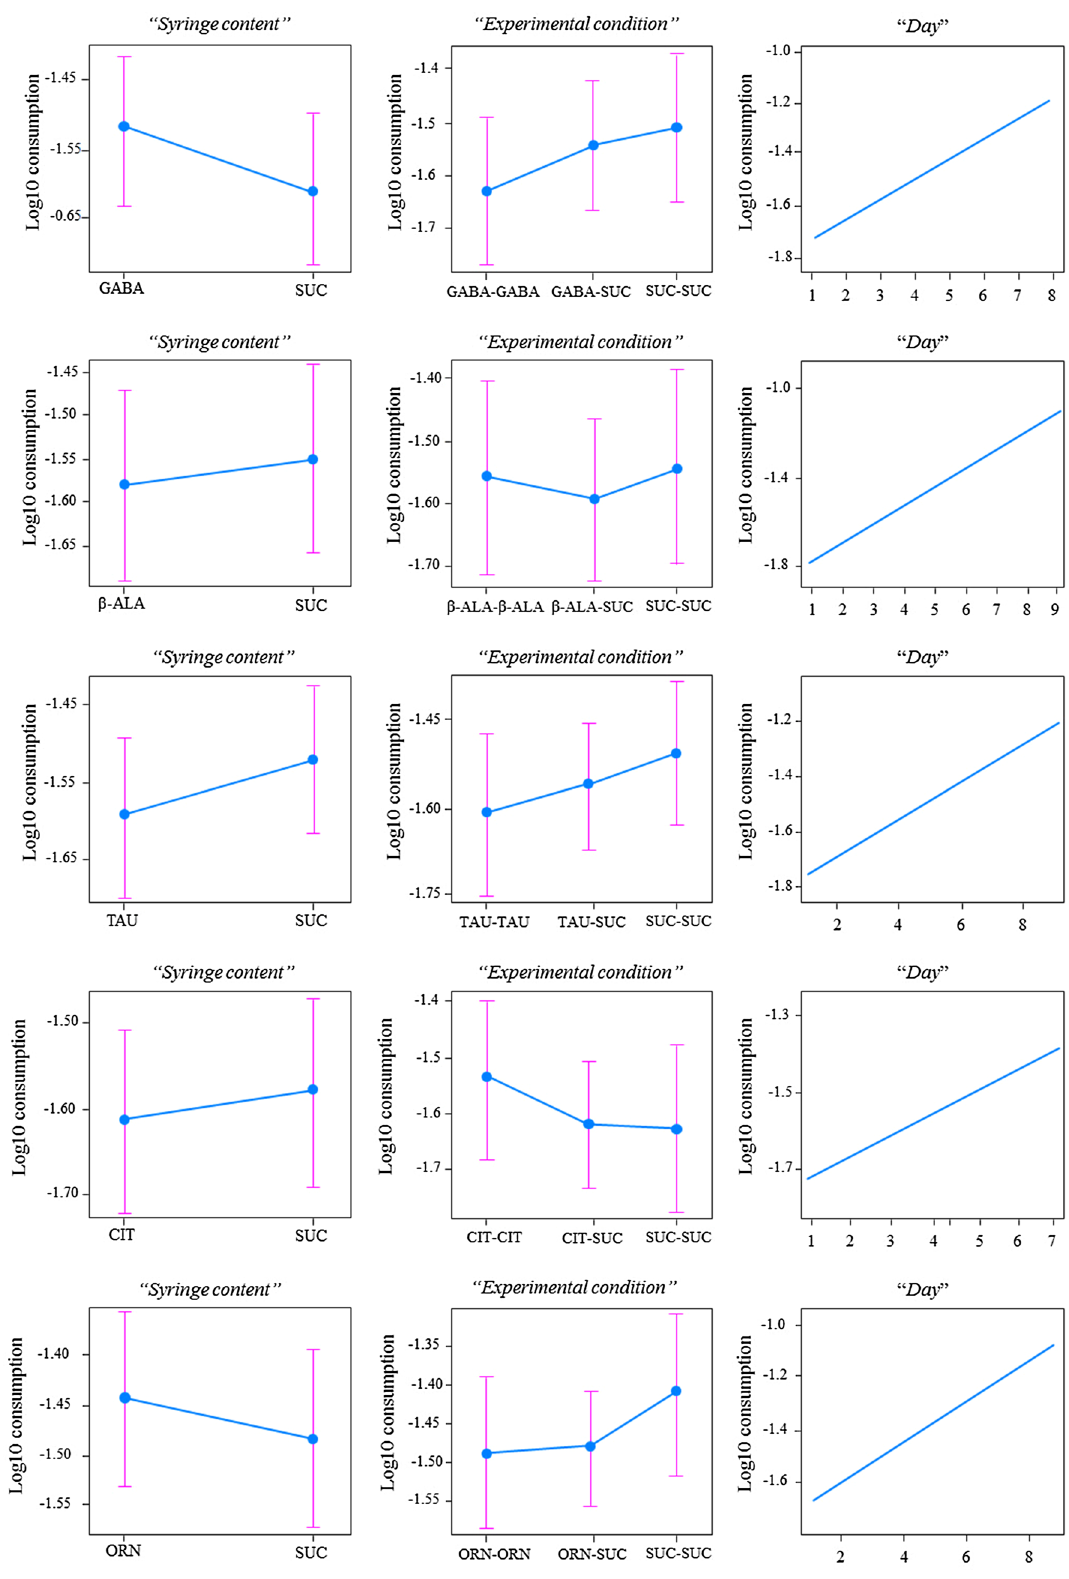
Figure 3. Nectar NPAAs did not affect food consumption by bees kept in caged conditions under three different feeding regimes for up to 10 days. Plots represent fitted means for the factors “ syringe content ” (NPAA vs Sucrose) and “ experimental condition ” (S–S, NPAA-NPAA, S-NPA) and the covariate time “day”. Overall, bees did not consume more NPAA-laced solutions compared to control ones (GLMM, Syringe : GABA: p = 0.31; β-ALA: p = 0.71; TAU: p = 0.34; CIT: p = 0.71; ORN: p = 0.53). Per capita food consumption increased over time in all groups (GLMM all group p < 0.001). NPAAs did not induce phagostimulation or loss of appetite (GLMM, Experimental condition : GABA: p = 0.58; β-ALA: p = 0.34; TAU: p = 0.64; CIT: p = 0.67; ORN: p =